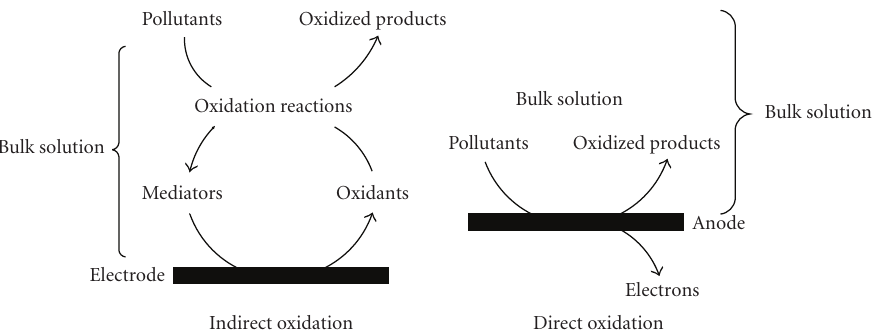
Figure 1: Pollutant removal pathways in electrochemical oxidation (indirect and direct oxidation) [57].